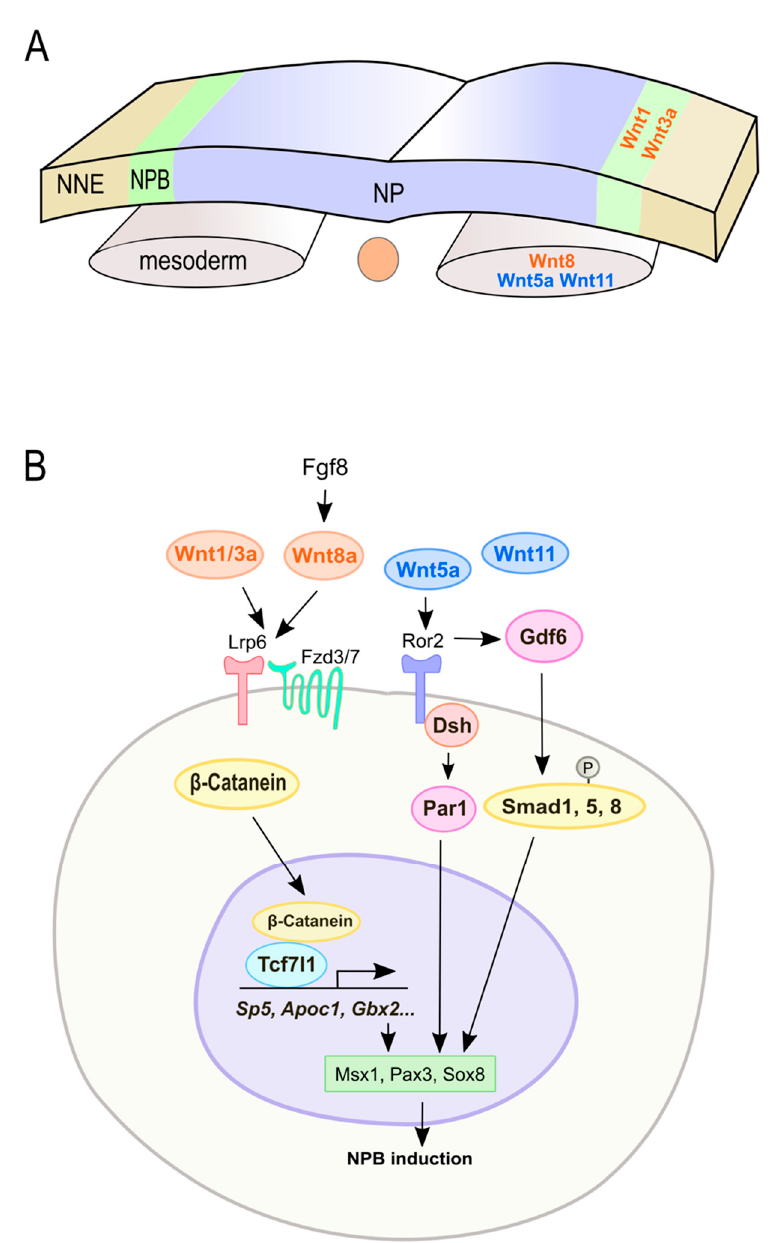
Figure 2. Wnt signaling regulates neural plate border (NPB) induction by regulating NPB specifiers. ( A ) NPB induction begins during gastrulation and is regulated by both canonical ( orange ) and non-canonical ( blue ) Wnts secreted from NPB and paraxial mesoderm. ( B ) Key components and possible interactions between Wnt signaling and NPB specifiers. NNE, non-neural ectoderm; NP, neural plate.